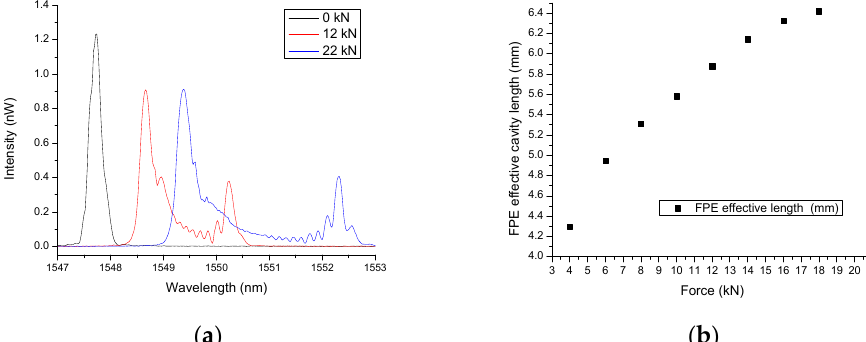
Figure 6. ( a ) Three distinct peaks spectral response with applied force of the 25 mm FBG. ( b ) FPE effective cavity length in mm with applied force.